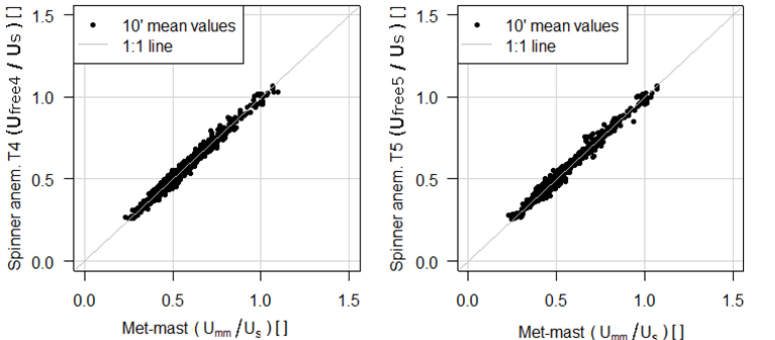
Figure 8. Calculated free wind speed as a function of measured free wind speed. Wind turbine 4 to the left and wind turbine 5 to the right. = 0 . 9840, R 2 = 0 . 9846. R 2 T4 T5